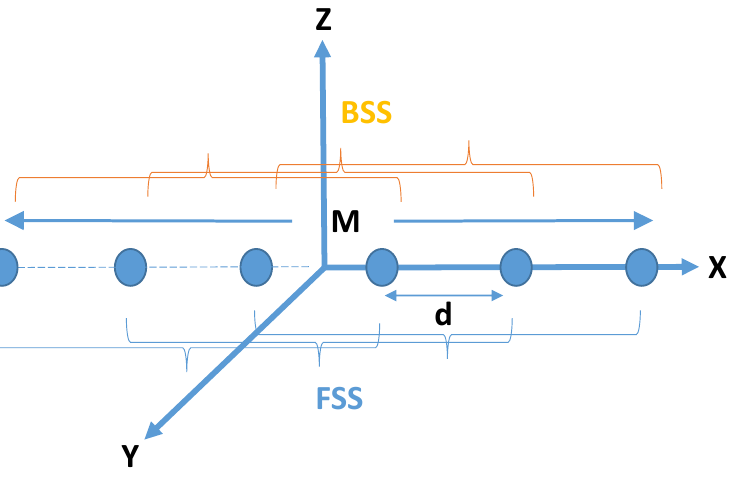
Figure 13. FBSS, 6 element array with 3 sub-arrays of size p =